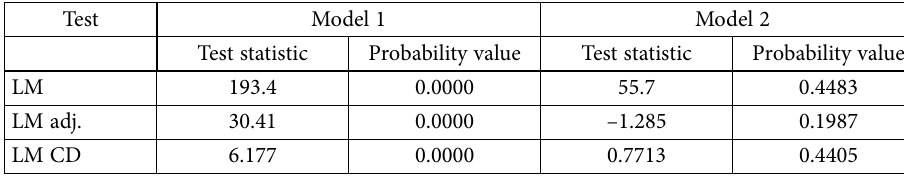
Table 3. Results of cross-sectional dependency tests